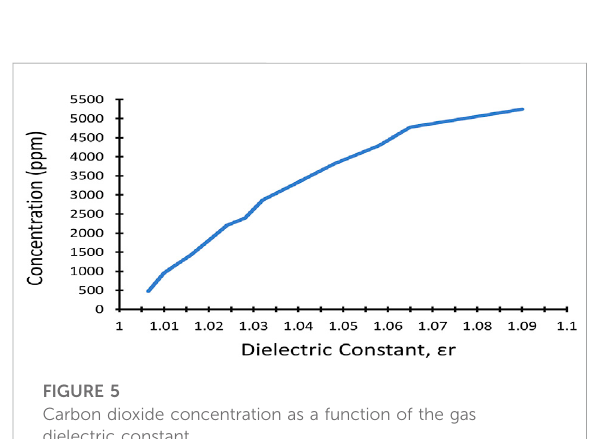
FIGURE 5 Carbon dioxide concentration as a function of the gas dielectric constant.